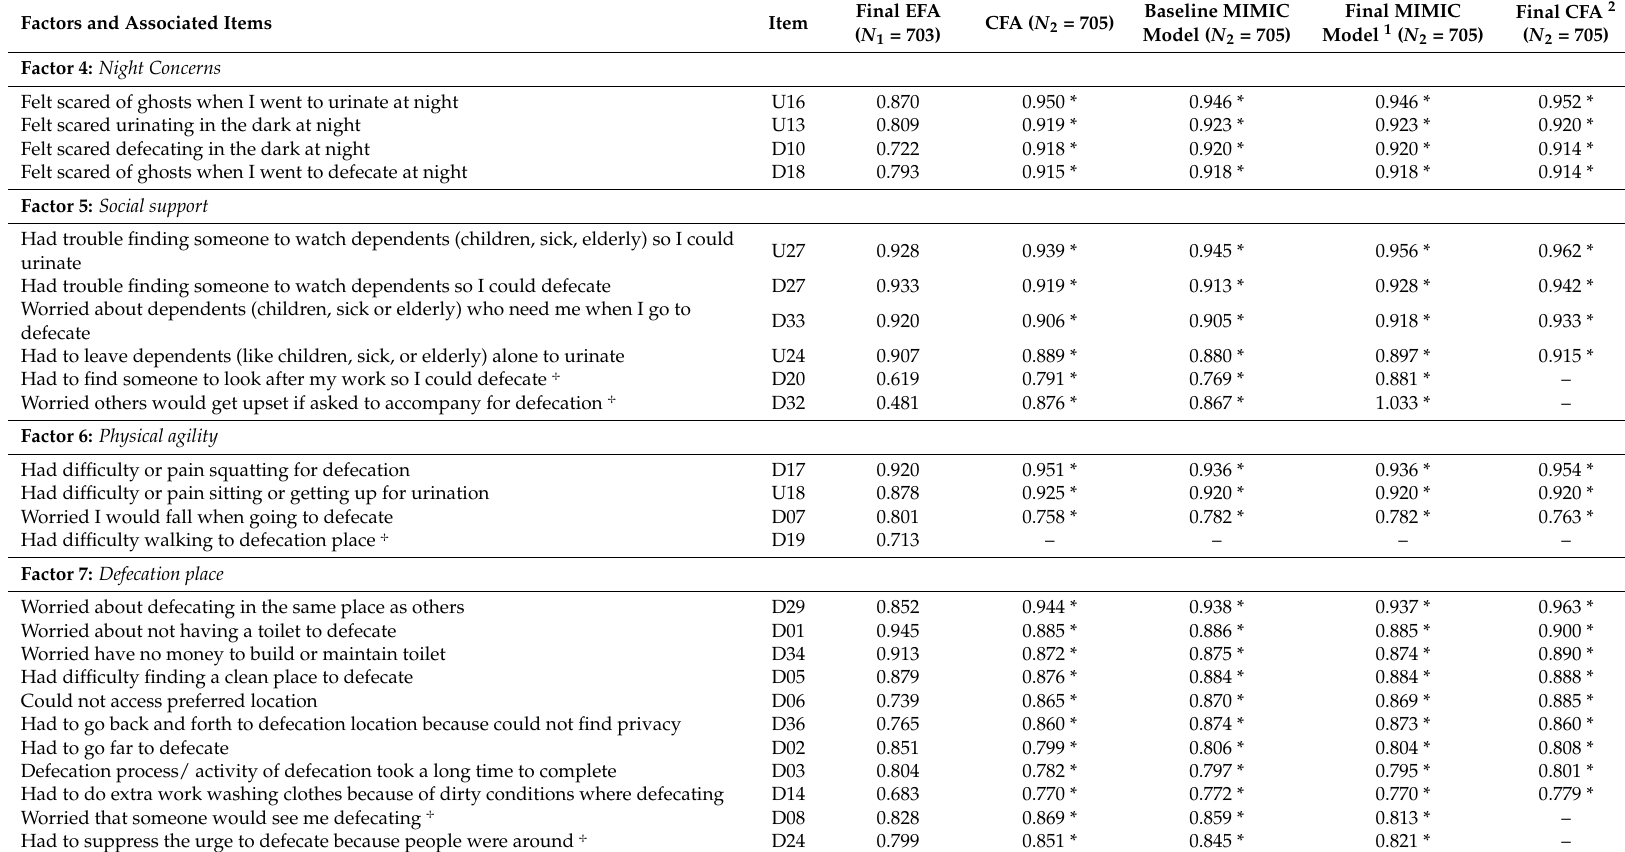
Factor 4: Night Concerns Felt scared of ghosts when I went to urinate at